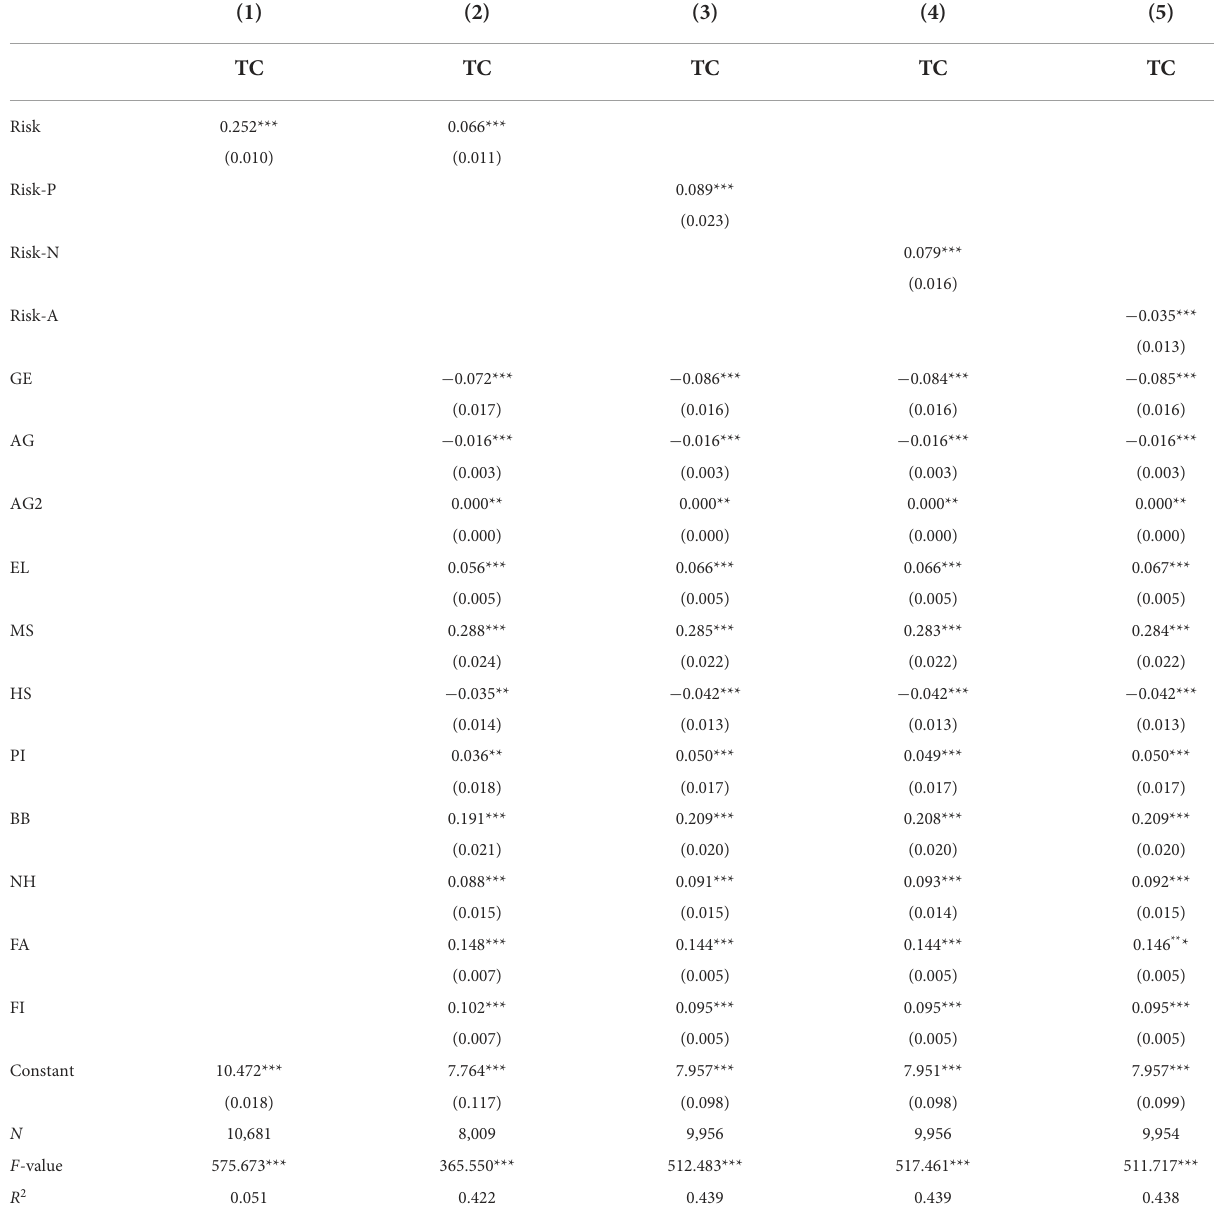
TABLE 3 The influence of risk attitude on household consumption